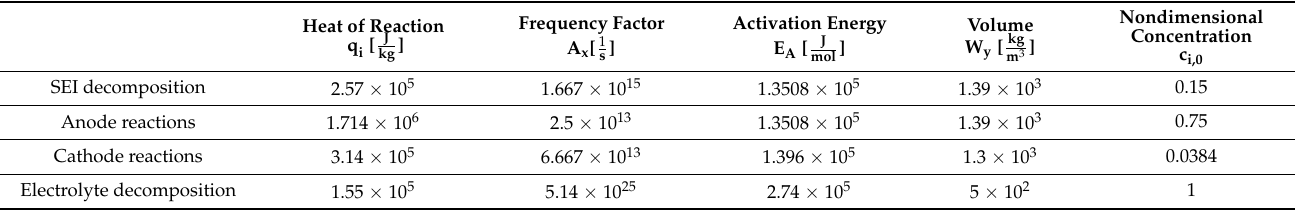
Table 4. Parameters for kinetic Equation (35)